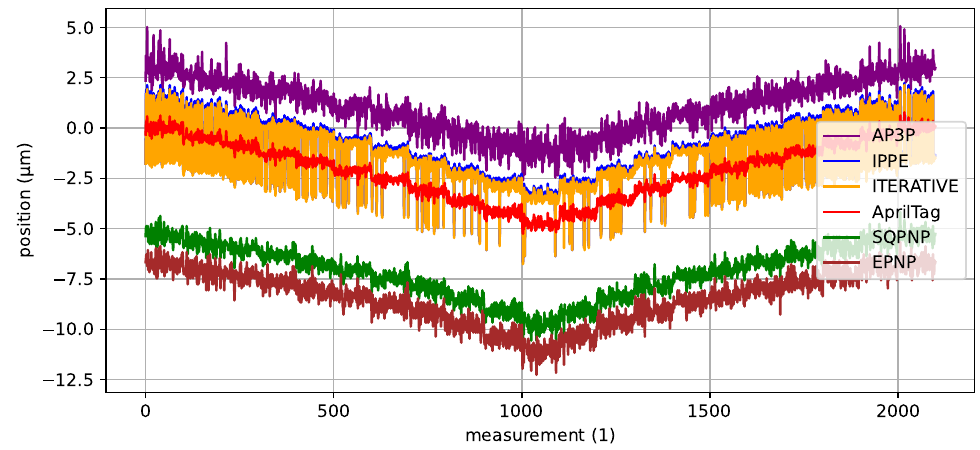
Figure 14. Comparison of various PnP algorithms on the achievable translational accuracy during a staircase motion in x -direction with a step size of